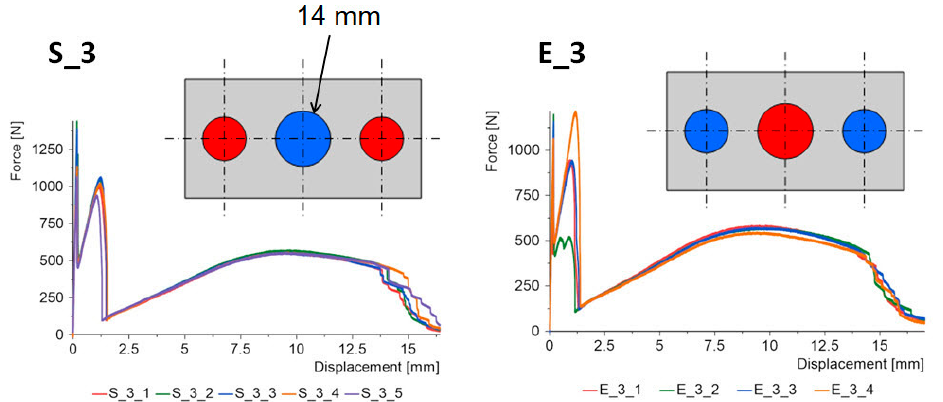
Figure 9. Triple-adhesive samples, batch 3.